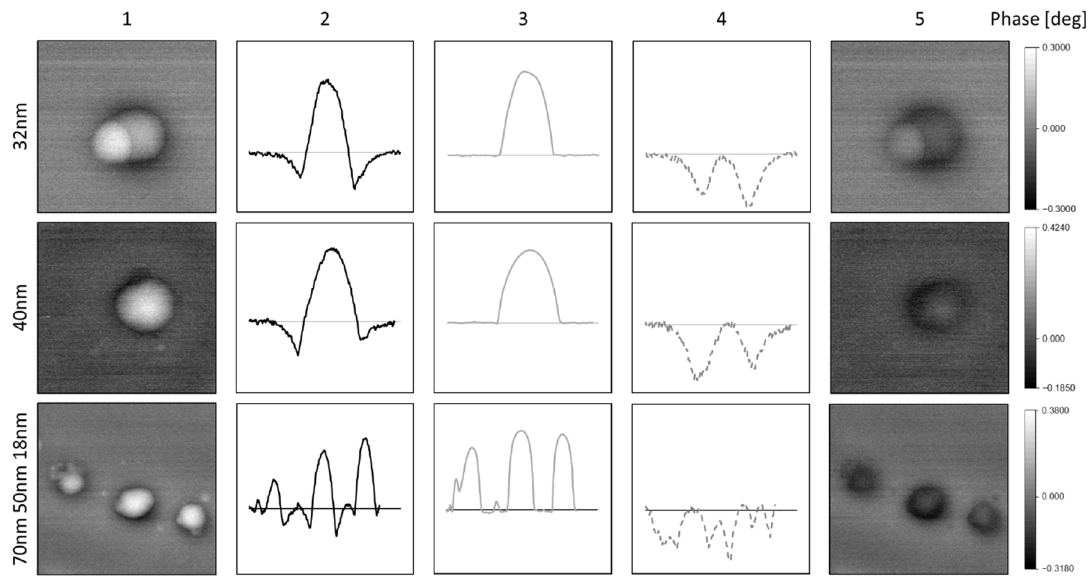
Figure 6. Data fusion for polystyrene particles filled with magnetite (ratio 1:0.2) with different diameters (top to bottom): ( 1 ) measured phase shift, ( 2 ) cross-section of measured phase shift, ( 3 ) calculated phase shift based on topographic cross-section, ( 4 ) cross-section of resulting phase shift by data fusion, ( 5 ) resulting phase image. (Silicon substrate; V CPD = 0.55 V; z = 50 nm; r tip = 80 nm).